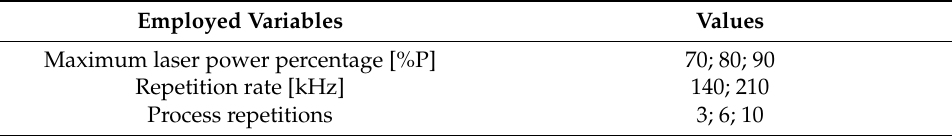
Table 2. Details of the experimental conditions for the laser